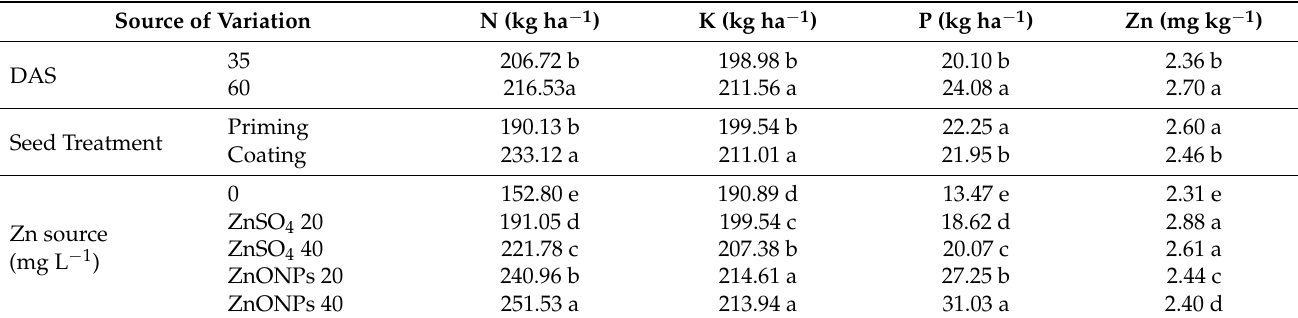
Means within the sub-factor followed by the same letter in a column are not significantly different at p ≤ 0.05 according to pair-wise comparison of least square